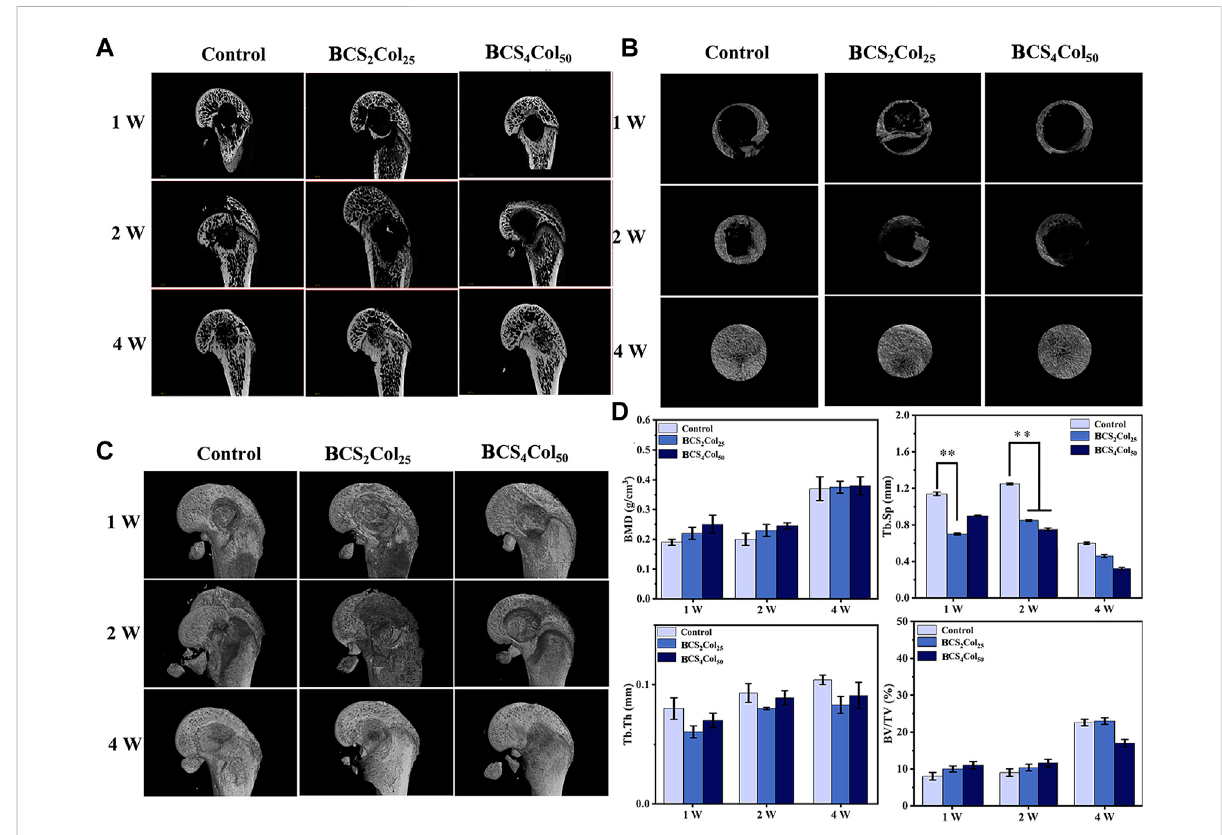
FIGURE 6 Micro-CT images of the femoral defects in rats after 1-, 2-, and 4-week operation. (A) Representative 2D micro-CT images. (B) Representative 2D micro-CT local magni fi cation images. (C) Representative 3D micro-CT images. (D) Quantitative analysis of bone mineral density (BMD), trabecular separation (Tb.Sp), trabecular thickness (Tb.Th), and relative bone volume (BV/TV) (* p < 0.05, ** p < 0.01, *** p <